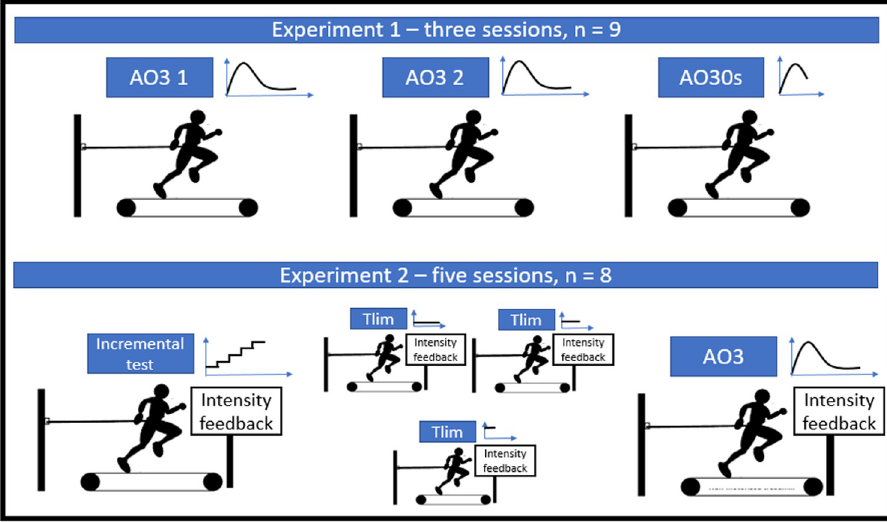
Fig 1. The study design. Study’s phase 1 tested the reliability of AO3 parameters and Pmax comparison to AO30s. Study’s phase 2 had a graded exercise test, three CWR intensities in a randomized order, finishing with one AO3. CWR was used for the classical CP model. All sessions were performed with 24–72 h intervals between them.